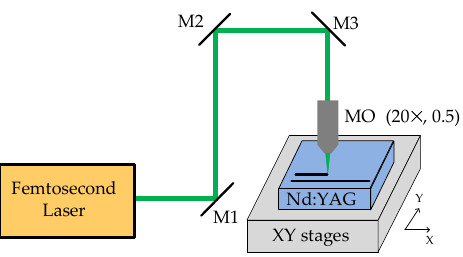
Figure 5. Schematic of the waveguide writing setup. Legend: MO, microscope objective.